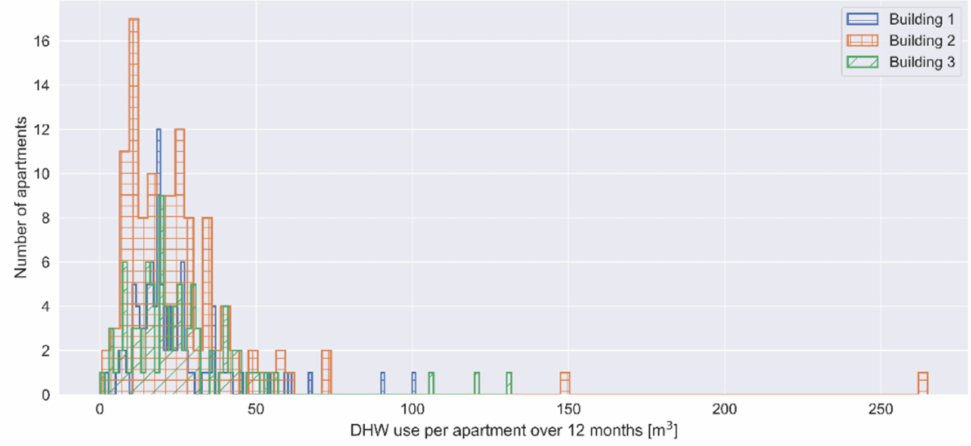
Figure 35. Domestic hot water consumption per